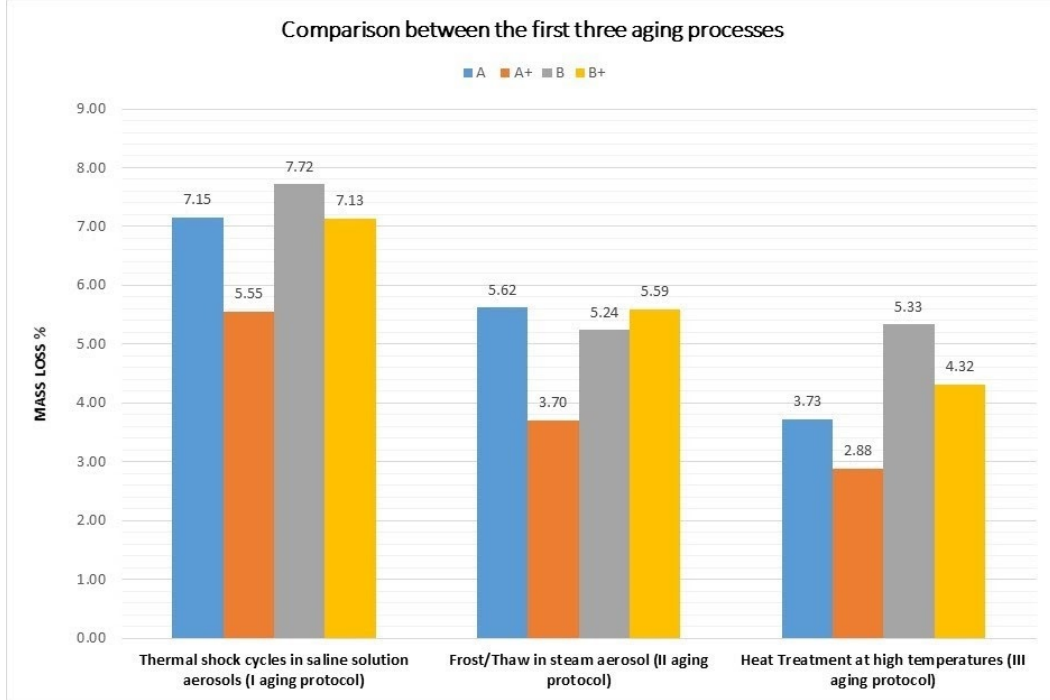
Figure 7. Comparison of aging protocols.